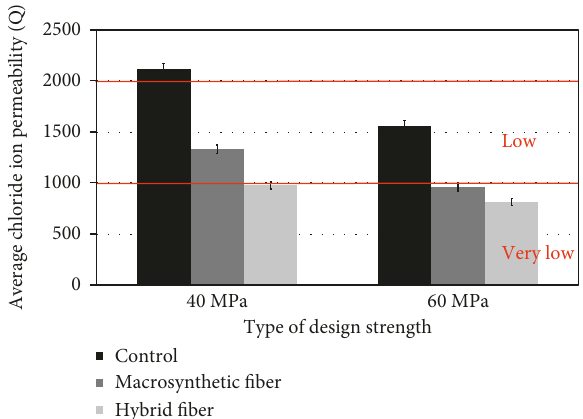
Figure 18: Chloride ion penetration of optimum mix ratio.